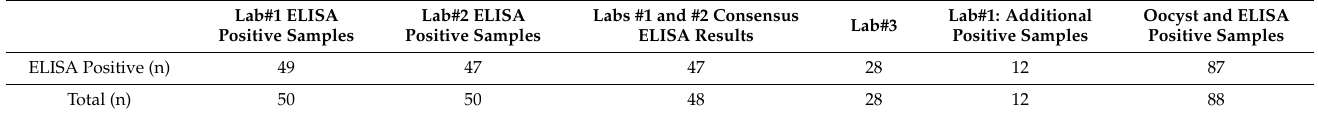
Table 3. Summary of ELISA results for Cryptosporidium spp. oocyst positive stool samples.